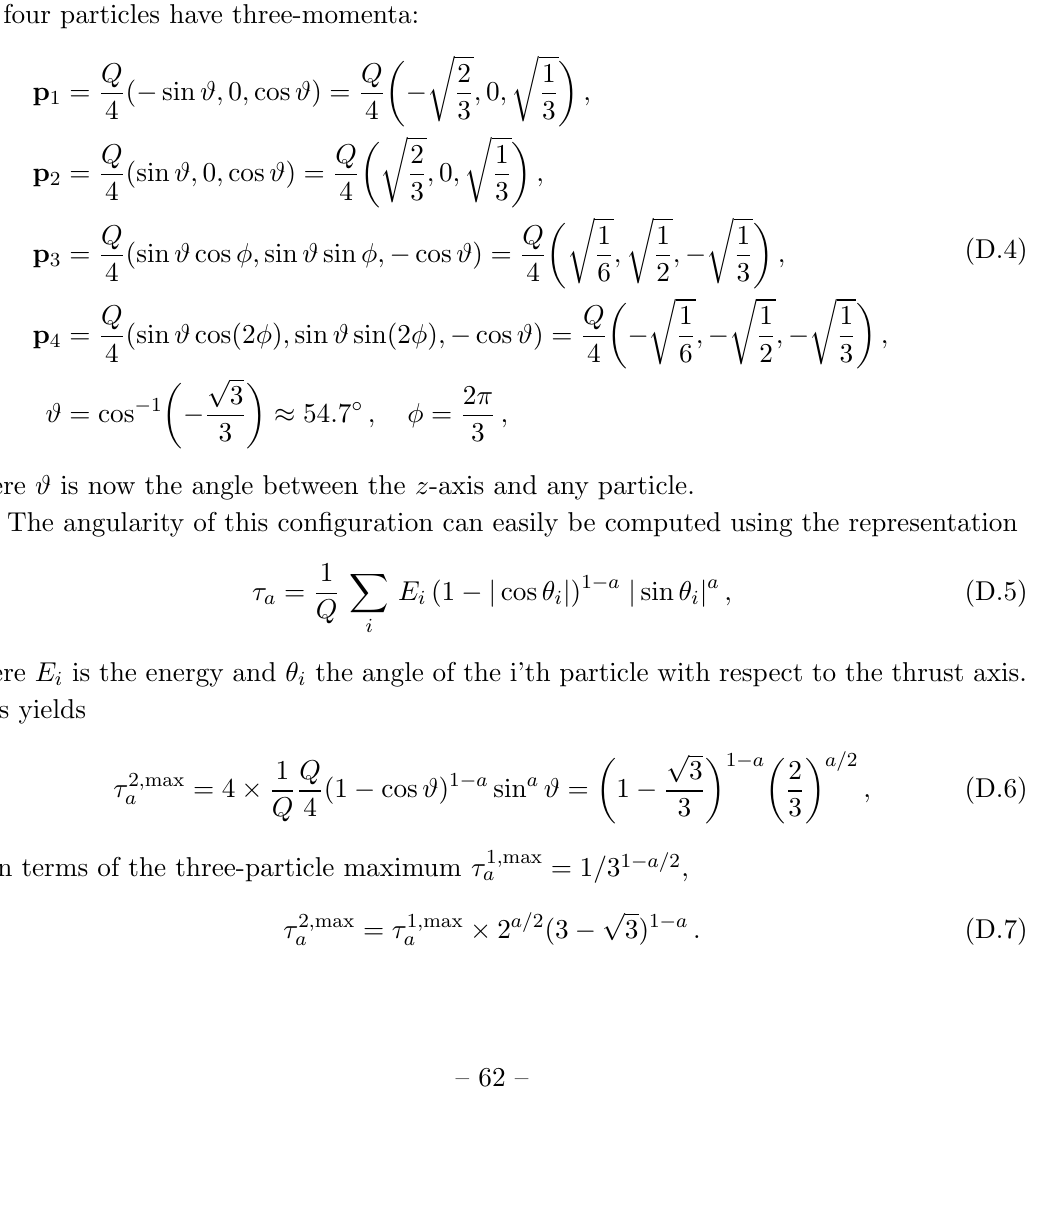
Figure 19 . Maximally symmetric four-particle con(cid:12)guration. The blue and green pairs of particles are in back-to-back hemispheres, and the thrust axis ^t is along the red vector, which is aligned with p 1 + p 2 or ( p 3 + p 4 (cid:0)